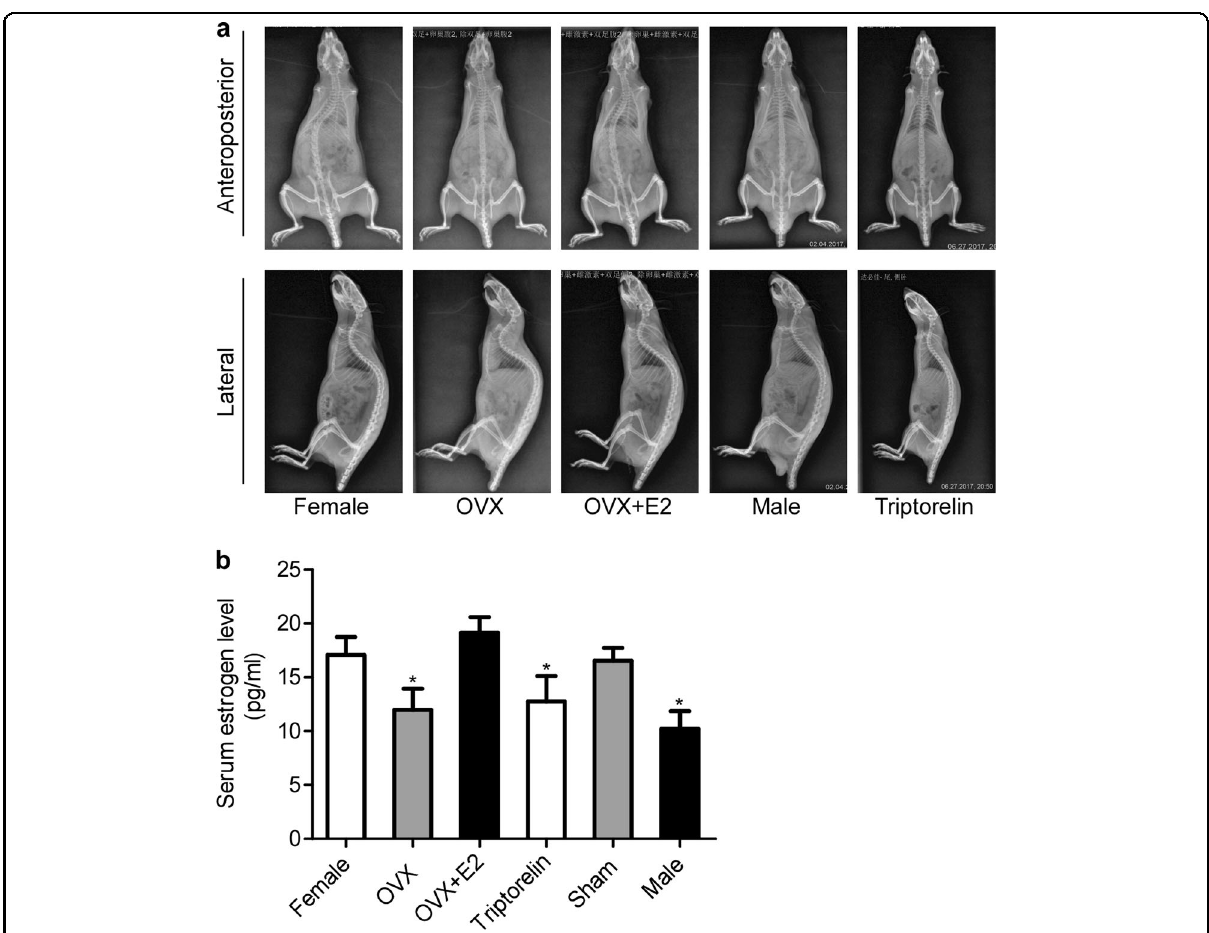
Fig. 1 The relationship between the onset of scoliosis and serum estrogen levels in bipedal rats. a At 15 th week after surgery, an obvious curve was observed on the radiographs from the female group and OVX + E2 group compared to the OVX, Triptorelin, and male groups. b Serum estrogen levels in all groups. At 15 th week after surgery, signi fi cantly lower circulating serum estrogen levels were observed in the OVX group, Triptorelin group, and male group than in the female group ( p < 0.05); * p < 0.05 compared with the female group Table 1 The incidence of scoliosis and scoliosis severity in all groups of bipedal rats Group Total, n Animals with Animals without Incidence of Slight (10 – 20 °) Moderate Severe deformity scoliosis scoliosis scoliosis (20 – 40°)